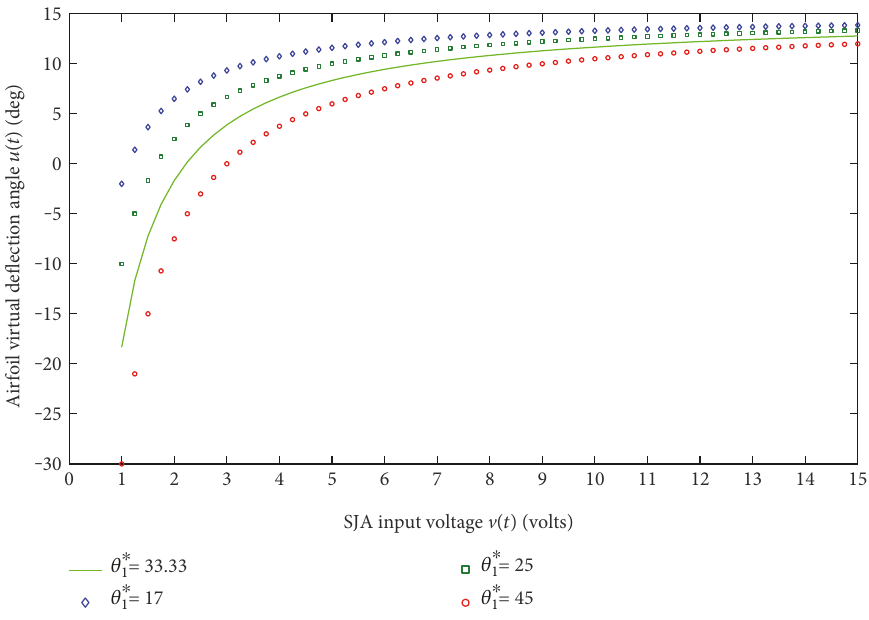
Figure 2: The virtual de fl ection angle versus control voltage for a SJA, showing the high degree of nonlinearity and the e ff ect of parametric uncertainty in the SJA dynamic model. A well-accepted nominal value for the parameter is shown in green, and the three other plots show the SJA dynamic characteristics under o ff -nominal operating